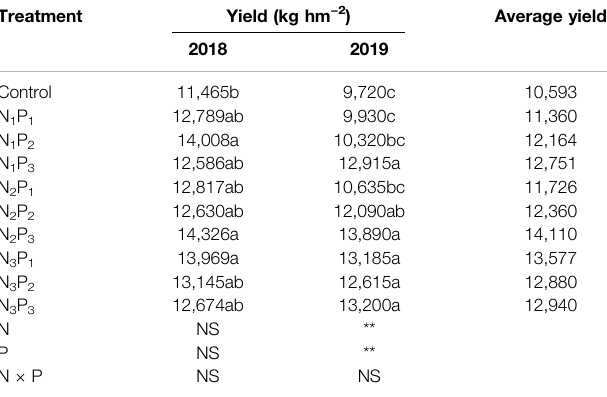
TABLE 4 | The yields of L. barbarum under different fertigation treatments.